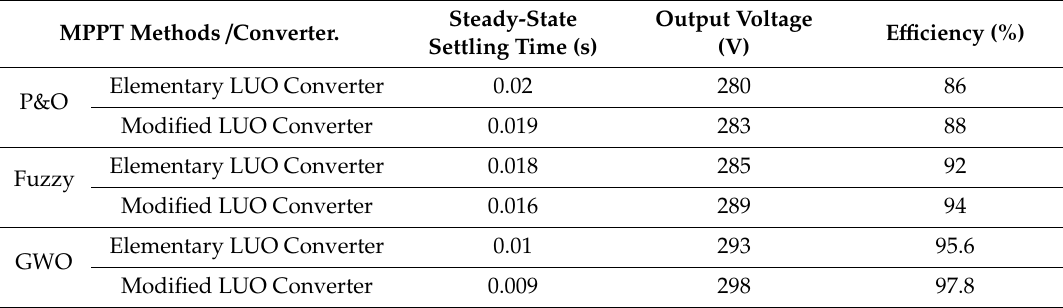
Table 2. Comparison of the MPPT methods for the elementary and modified LUO converters with